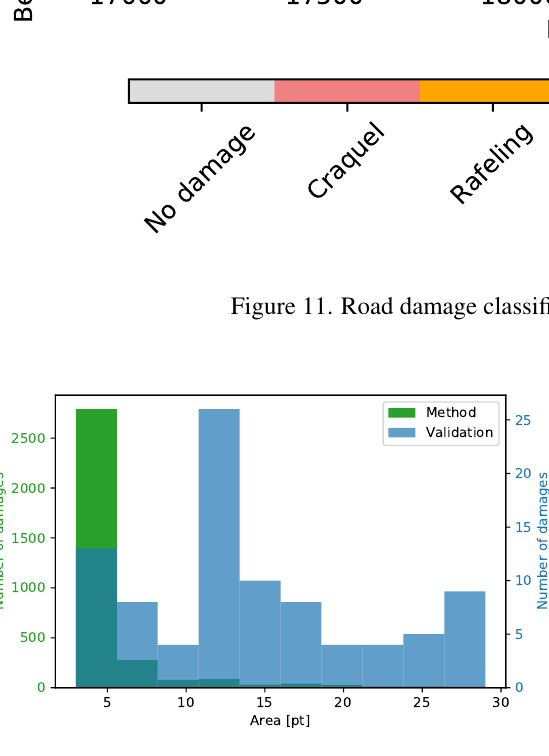
Figure 12. Damage area distribution of validation and method